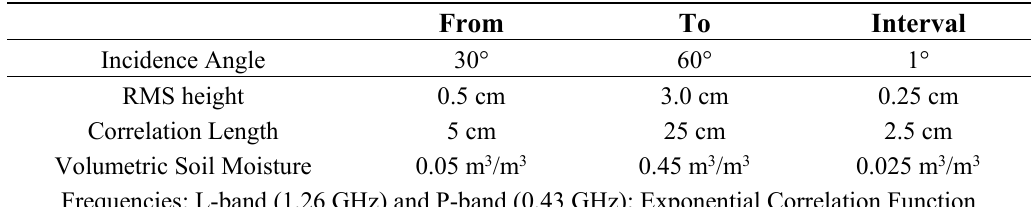
Table 4. Input parameters for the AIEM simulation database.